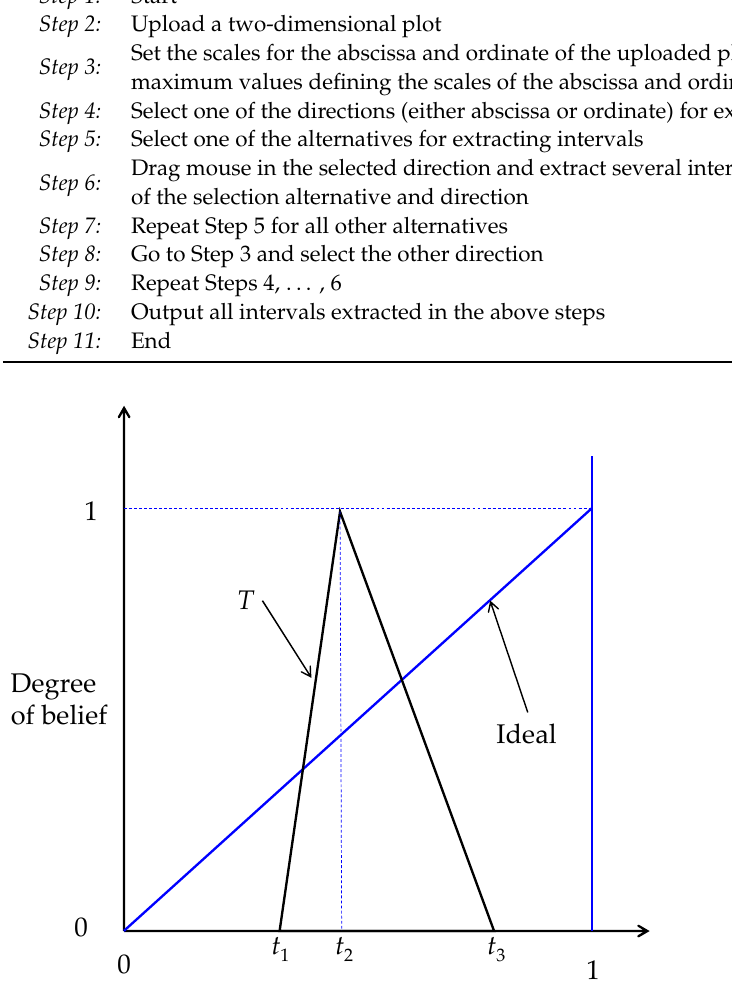
Figure 4. Calculating decision score.